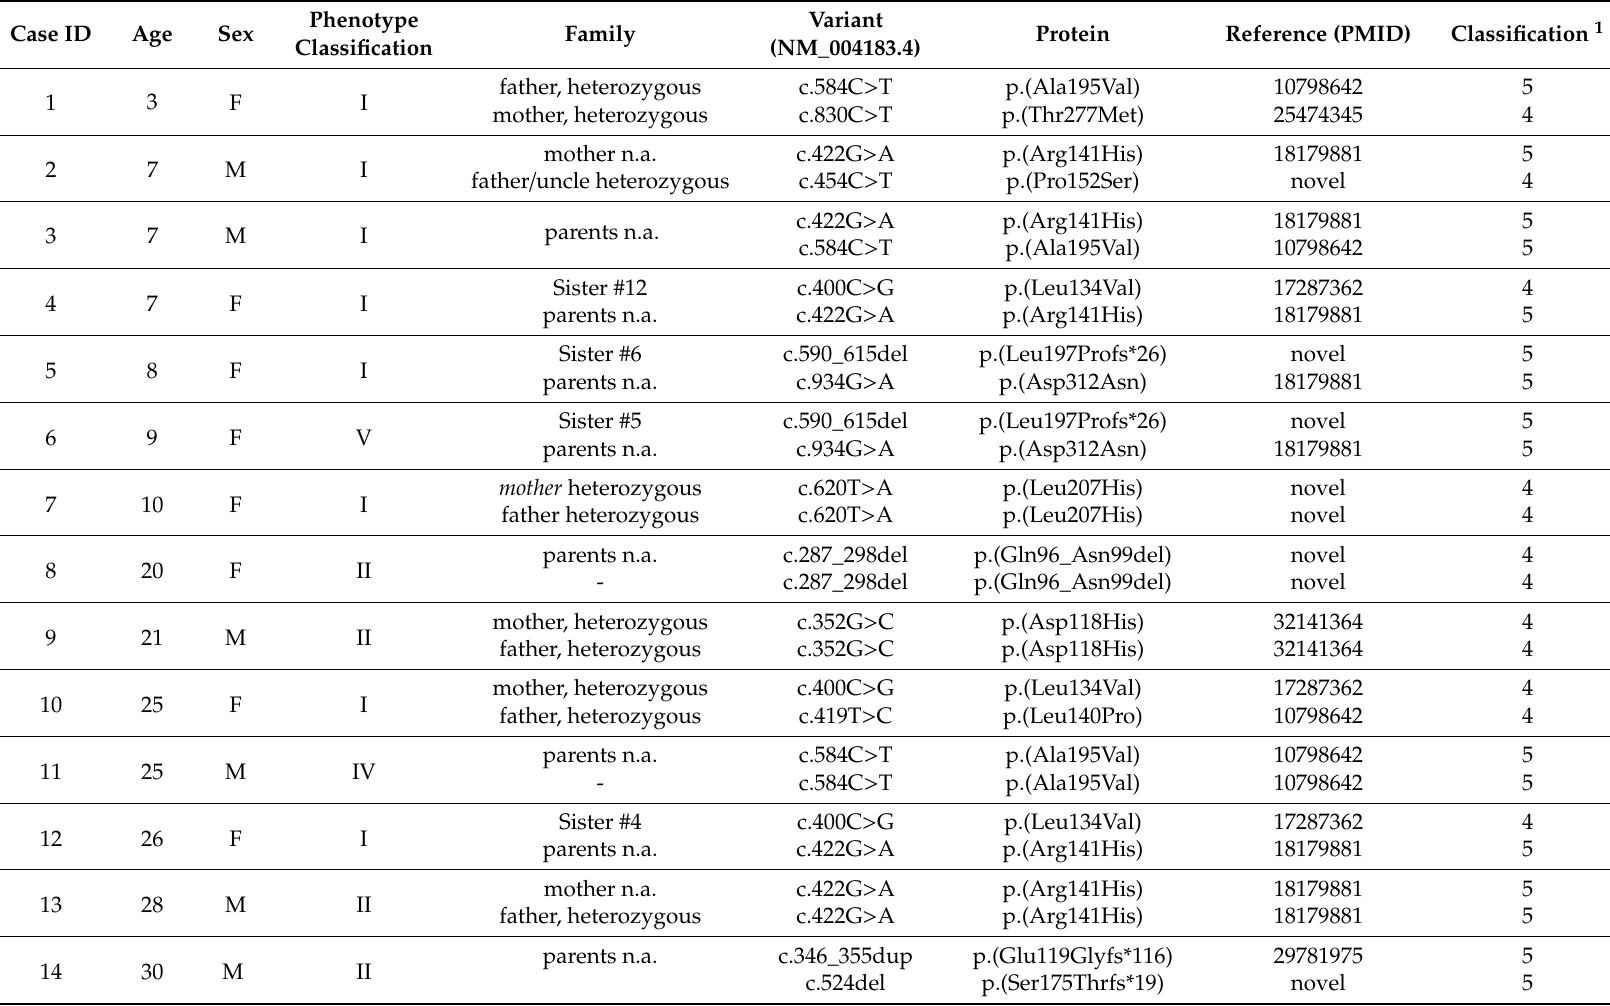
Table 2. Genetic data from BEST1 DNA